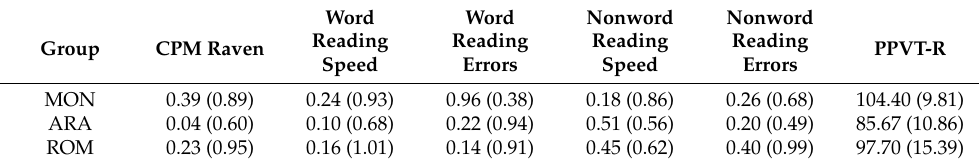
Table 1. Means (SDs) of the three groups in the preliminary measures. Group CPM Raven